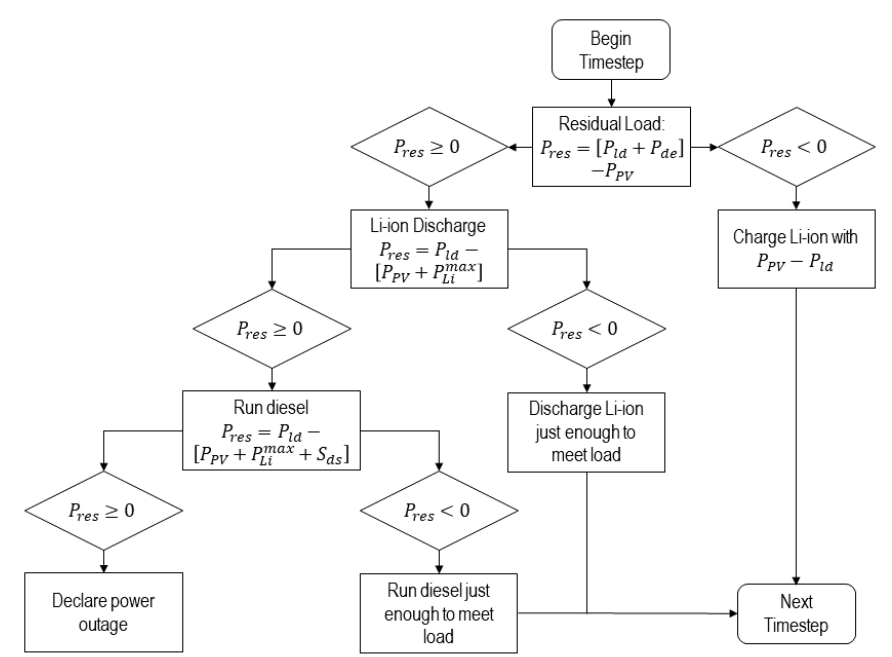
Figure A3. Load-following dispatch algorithm used by ISLA. To reduce carbon emissions, the system prioritizes the usage of stored Li-ion BESS energy over diesel power if solar PV power is insufficient.